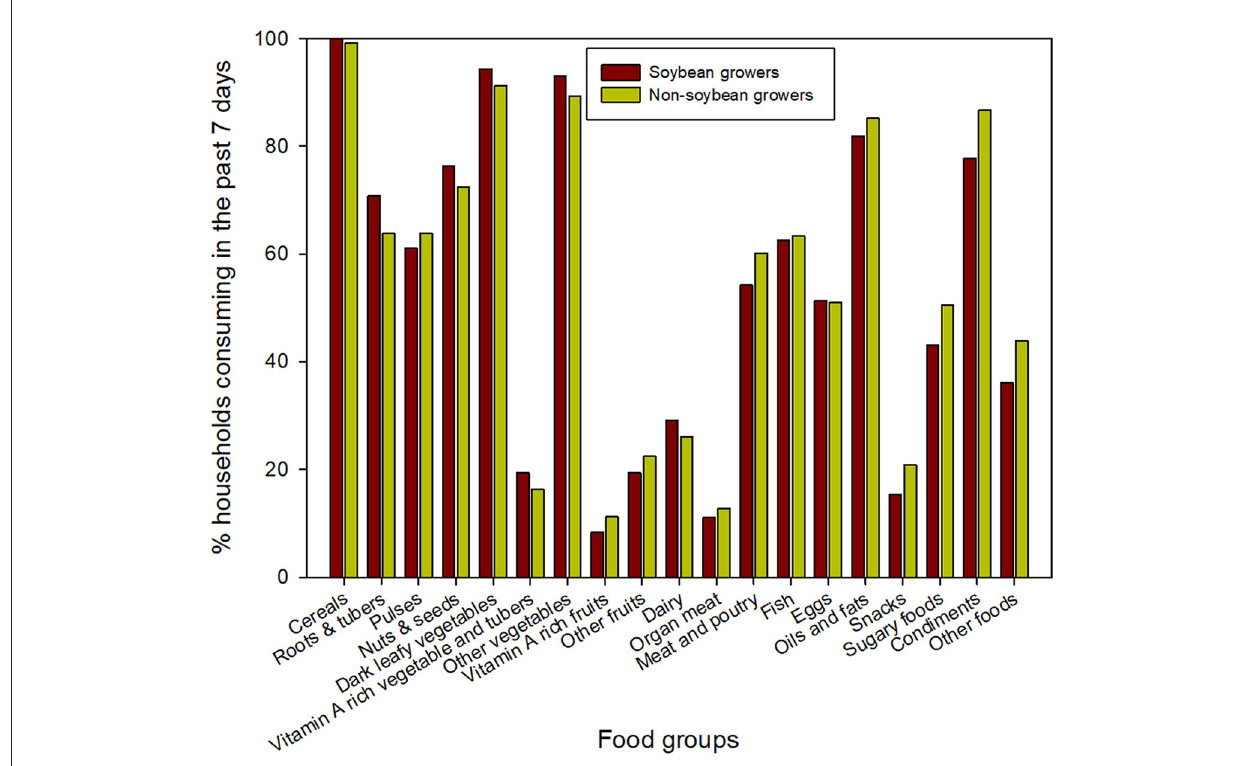
FIGURE3 Percentage of women from households who reported consuming a food group in the past 7 days.